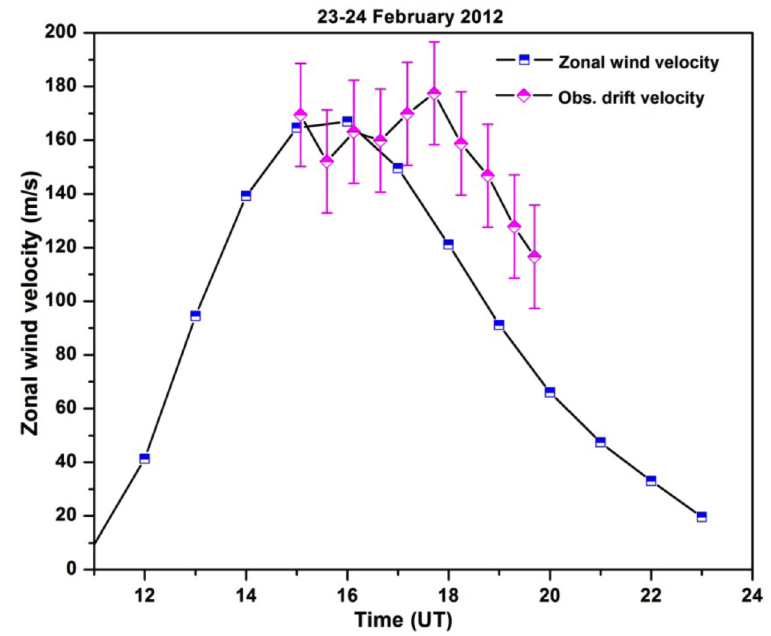
Figure 13. Same as Figure 12, but on 23-24 February